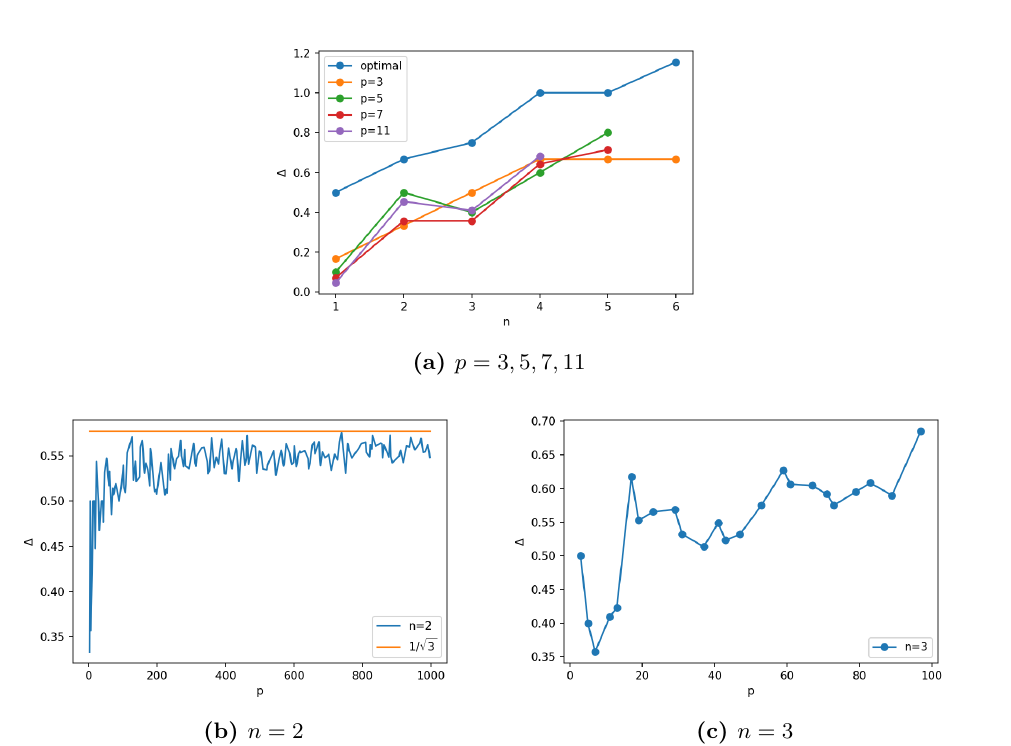
. p generated by (¯ a, ¯1) T p